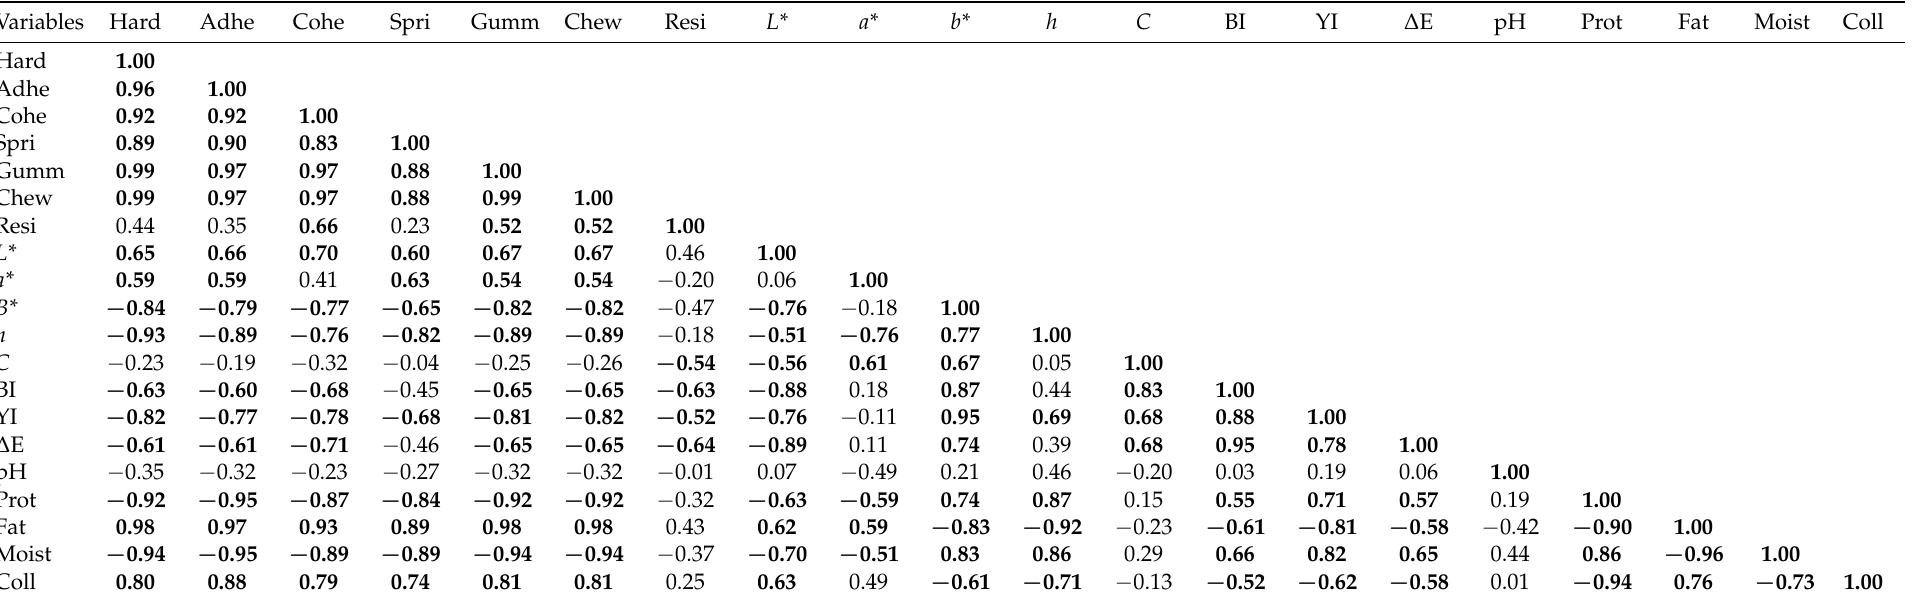
Table 8. Pearson correlations